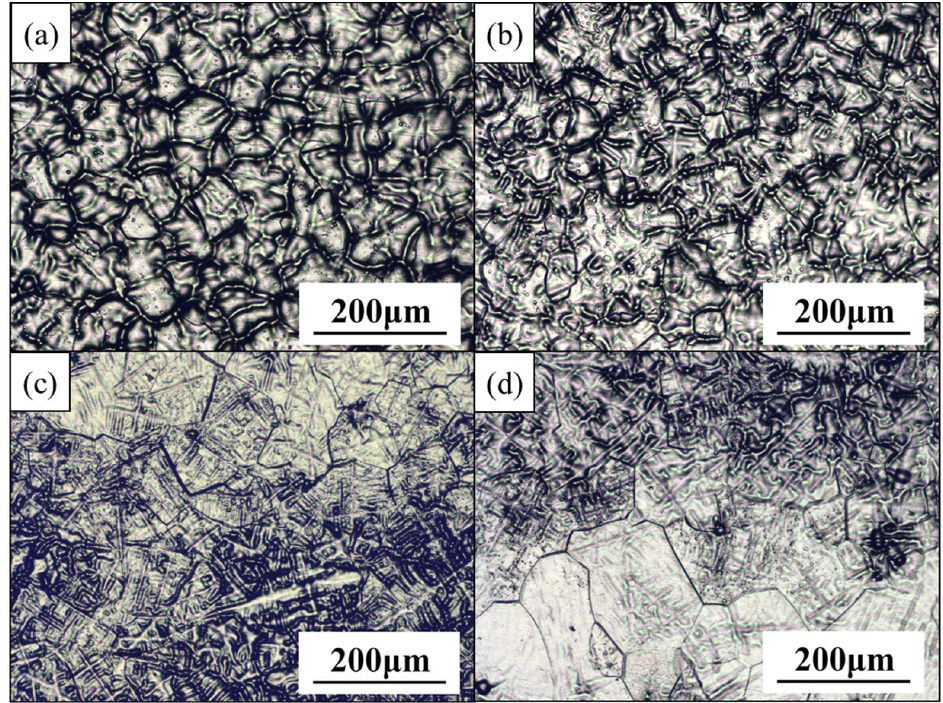
Figure 1. The XRD patterns of the as-cast Ti 65 (AlCrNbV) 35 and Ti 65 (AlCrNbV) 35-x Zr x (x = 3, 5, 7, 10) MEAs.